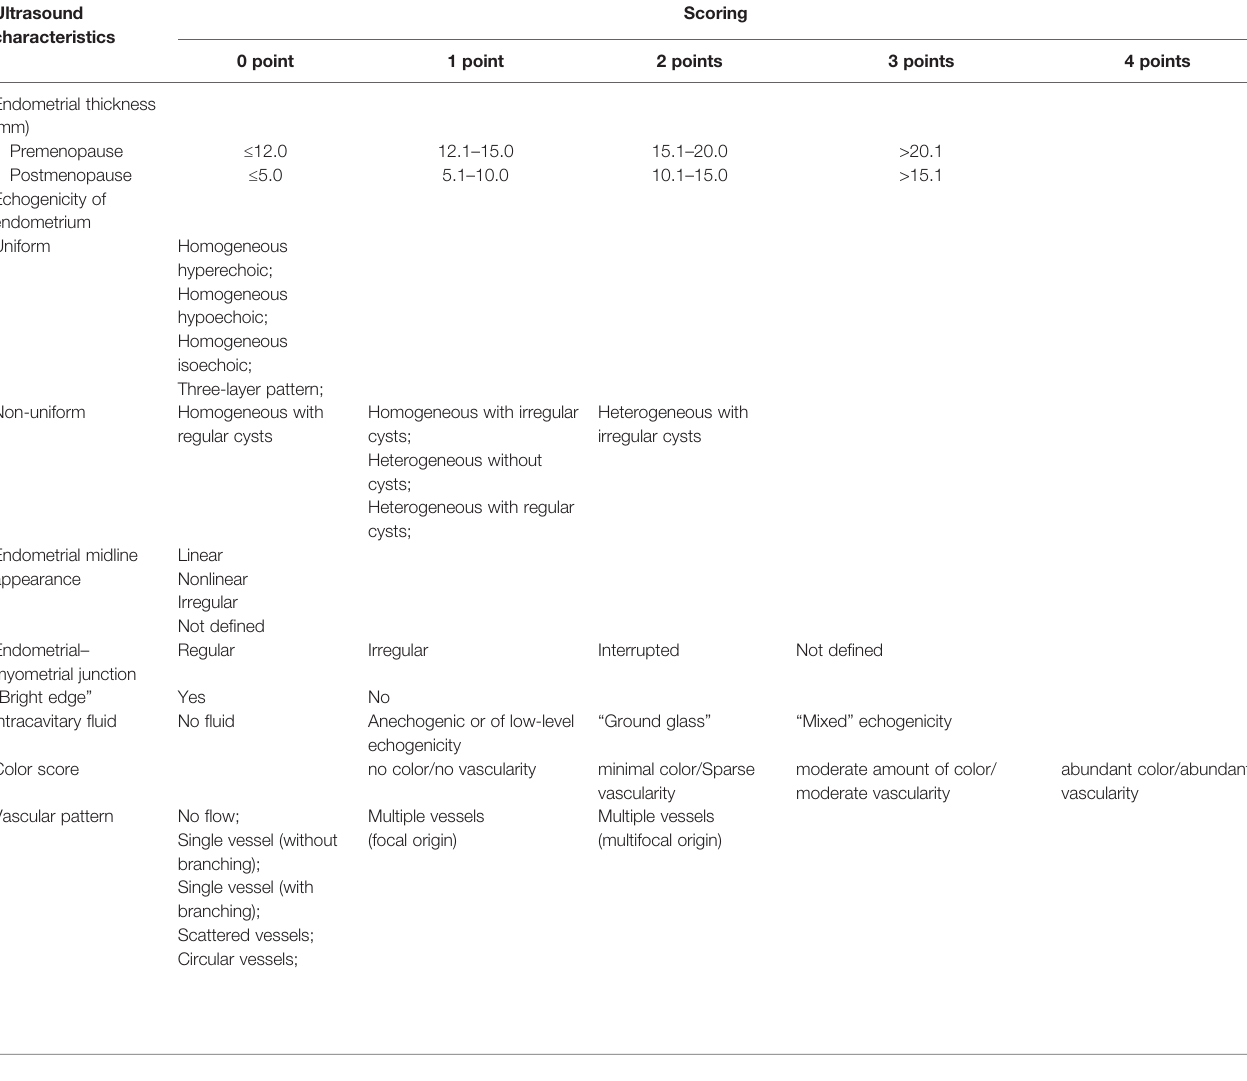
TABLE 1 | The reference table of IETA ultrasound characteristics simple scoring method. Ultrasound characteristics